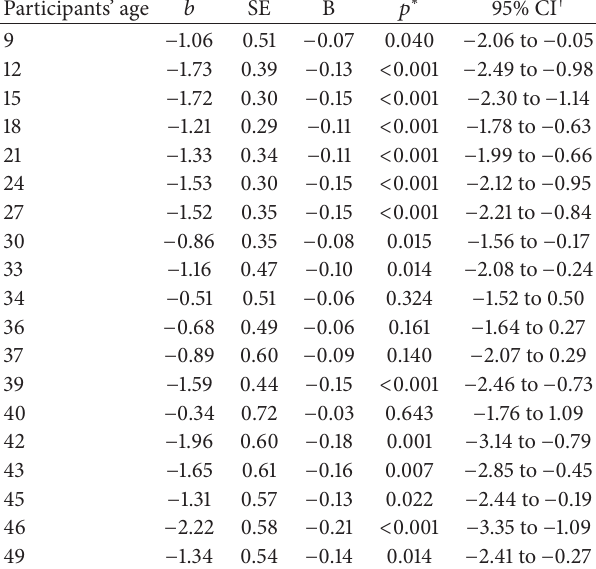
Figure 2: Symptoms of depression (2012) in the physical activity trajectory groups in unadjusted ∗ and adjusted models ∗† ( 𝑛 = 3564). ∗ Standard errors are represented in the figure by the error bars attached to each column. † Participants’ age, sex, childhood negative emotionality, parental education, parental income (1980), previ- ous symptoms of depression (1992–2007), participants’ education, income, social support, body mass index, and smoking status (2007) were adjusted for in the